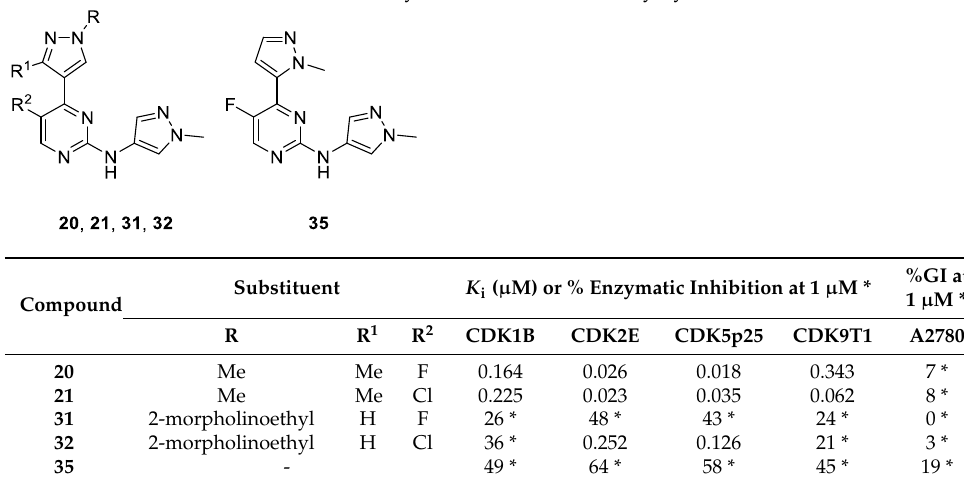
Table 2. Inhibition of CDK kinase activity and A2780 cell viability by 20 , 21 , 31 , 32 , and 35